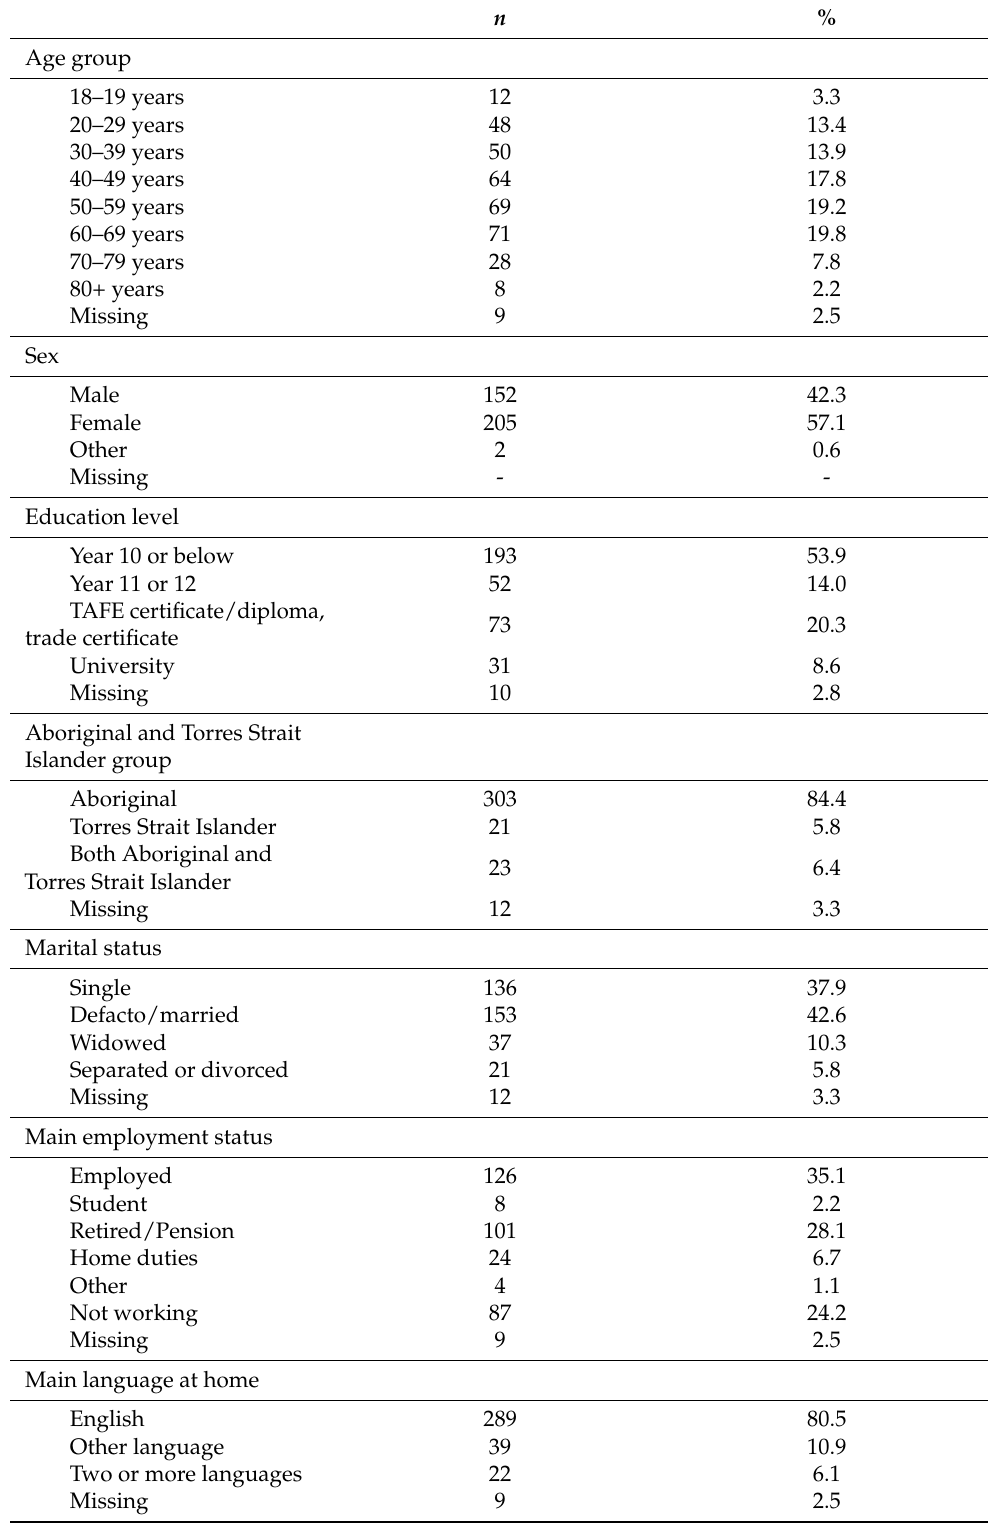
Table 1. Socio-demographic characteristics of What Matters sample ( n =